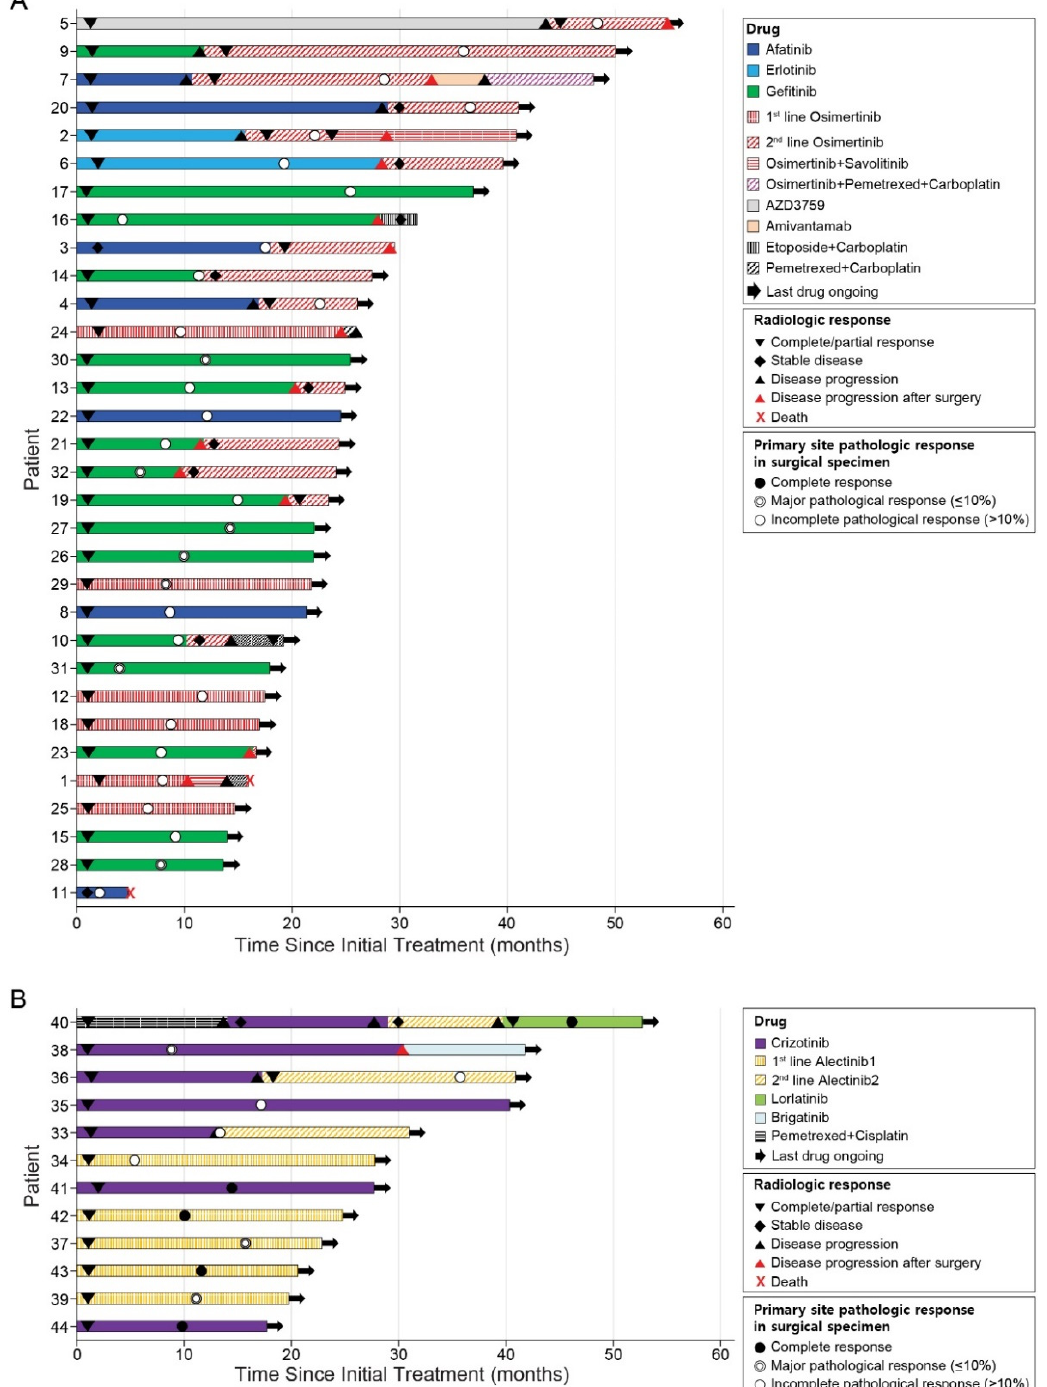
Figure 1. Survival of patients with oncogene-driven advanced NSCLC after the initial treatment. ( A ) The swimmer plot of the 32 patients with EGFR mutations. ( B ) The swimmer plot of the 12 patients with ALK or ROS1 fusions. In 21 patients (47.7%), other metastatic lesions were treated with surgery ( n = 4, 9.1%), radiation therapy ( n = 15, 34.1%), or a combination thereof ( n = 2, 4.5%) prior to pulmonary resection. At the primary lesion, 6 patients (13.6%) had partial response, 30 (68.2%) pre- sented with stable disease, and 8 (18.2%) experienced disease progression. At the meta- static site, 19 patients (43.2%) had no radiologic evidence of disease, 2 (4.5%) had partial response, 21 (47.7%) had stable disease, and 2 (4.5%) experienced disease progression. Of the two patients with disease progression in the metastatic lesion, one underwent addi- tional wedge resection of the metastatic lung lesion during surgery, whereas the other